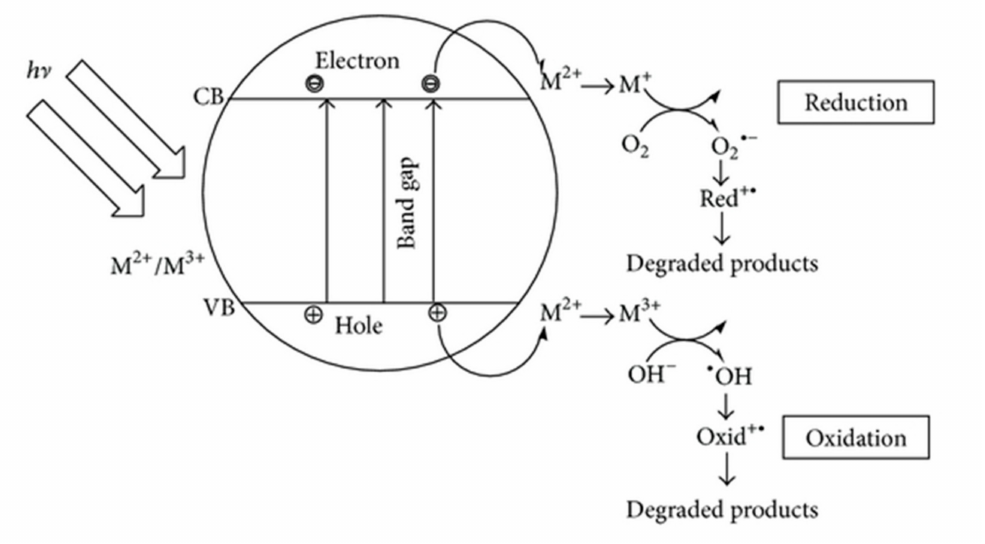
Figure 3. The basic mechanism of photocatalysis